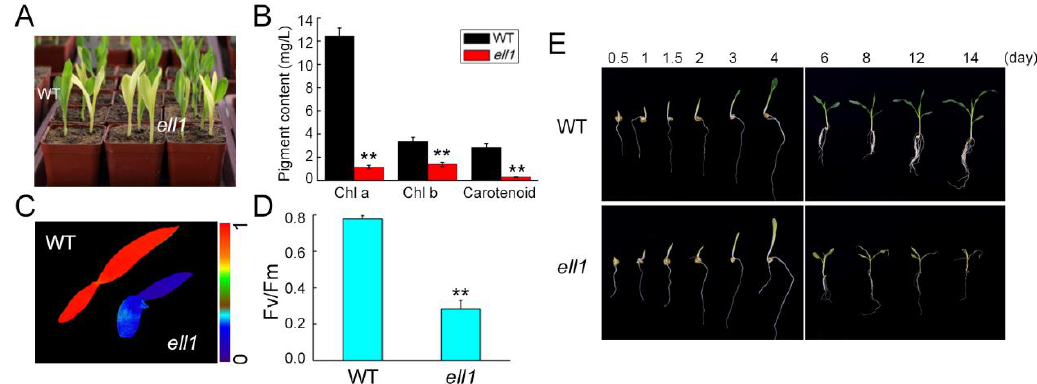
Figure 1. Identification and characterization of the maize ell1 mutants. ( A ) Identification of the ell1 mutant. Six-day-old seedlings of WT (seedlings with green leaves) and mutants (seedlings with yellow leaves) were photographed. ( B ) Analysis of the pigment content of the ell1 mutant and WT plants. Pigments were extracted from the three-leaf stage seedlings and were determined with a UV/VIS spectrophotometer measuring absorbencies at 665, 649 and 470 nm, respectively. ( C ) False-color images representing the maximum quantum yield of PSII photochemistry of the WT and the ell1 mutant. The photosynthetic parameter Fv/Fm was measured after dark adaptation for 30 min using a CF Imager system, the color scale (0 to 1.0) on the right represents the signal intensities for Fv/Fm ( C ). ( D ) Calculation of Fv/Fm in the WT and the ell1 mutant. Fv/Fm was calculated as (Fm-Fo)/Fm. ( E ) Growth and development of the WT and ell1 mutant. Photographs were taken from germination to the three-leaf stage of WT and ell1 . Asterisks indicate where WT and ell1 differ significantly (** p < 0.01, Student’s t -test). All data is presented as the means ± SD ( n ≥ 3).